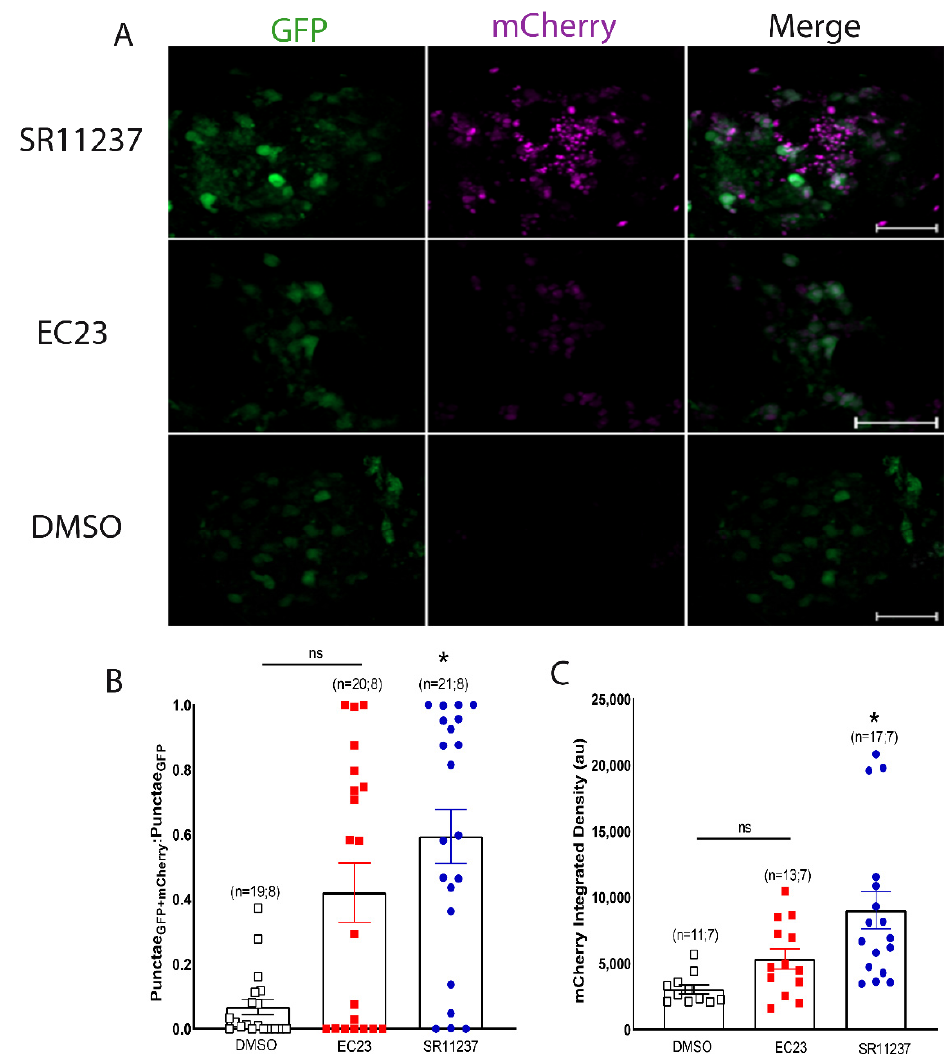
Figure 6. Sensor activation by a vertebrate RXR agonist. ( A ) Representative images of CNS hemi- spheres following heat-shock, showing the highest level of sensor activation by the vertebrate RXR agonist SR11237 (1 μ M), though also some activation by the synthetic retinoid and RAR-selective agonist, EC23 (1 μ M). ( B , C ) Despite no significant increase in the proportion of GFP punctae also containing mCherry in the CNS exposed to EC23, compared to vehicle controls (0.01% DMSO), there is some level of transcriptional activity by the sensor in response to EC23. The proportion of GFP punctae also expressing mCherry is, however, significantly higher in CNS exposed to the vertebrate RXR agonist SR11237 ( B ), as is the mCherry integrated density, compared to DMSO controls ( C ). * p < 0.05, compared to DMSO. Numbers in brackets represent total number of CNS and number of separate trials. Scale bars: 50 µ